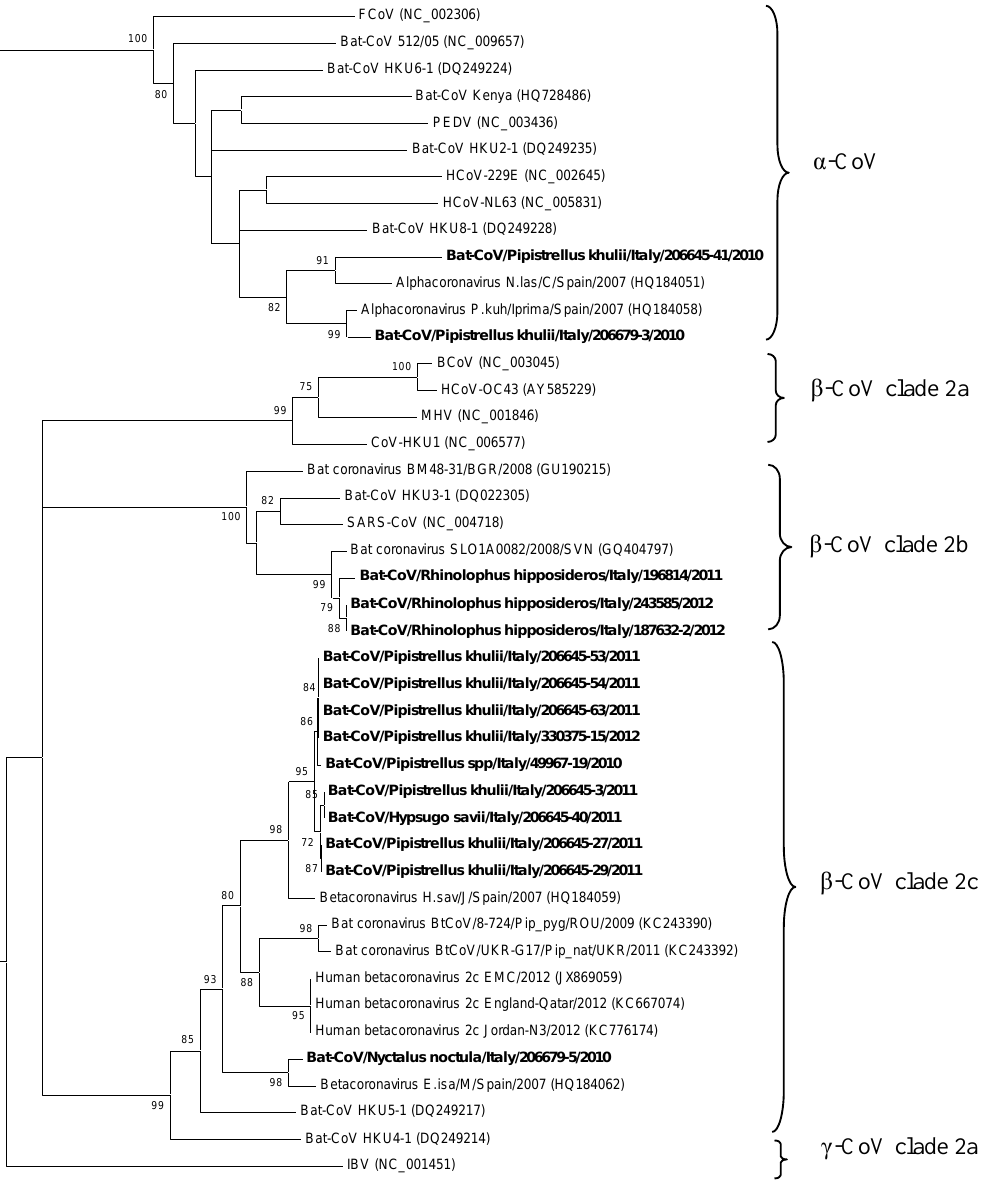
Figure 1. Phylogenetic tree of the partial RNA-dependent RNA polymerase ( RdRp ) gene (385 bp) of coronavirus (CoV) strains found in bats. The unrooted tree was generated by the MEGA5 program using the Neighbor-joining method. The evolutionary distances were computed using the Maximum composite likelihood model. Bootstrap values were calculated on 1,000 replicates and only values higher than 70% are shown. Coronavirus sequences detected in this study are shown in bold